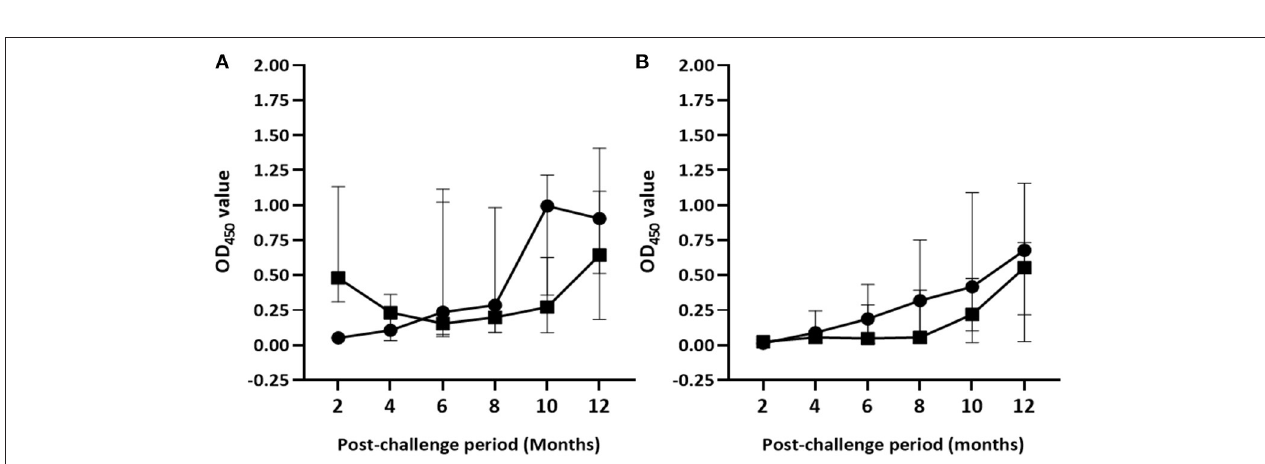
FIGURE 4 | Post-exposure IFN- γ responses in the experimental calves. The figure demonstrates kinetics of IFN- γ response to PPD (B-A) (A) and ESAT-6/CFP-10 peptides cocktail (B) in the control and vaccinated calves. The IFN- γ response was measured by optical density units (OD 450 ). Solid circle and solid square error bars indicate the median ( ± 95% CI) OD 450 value of control and vaccinated calves,